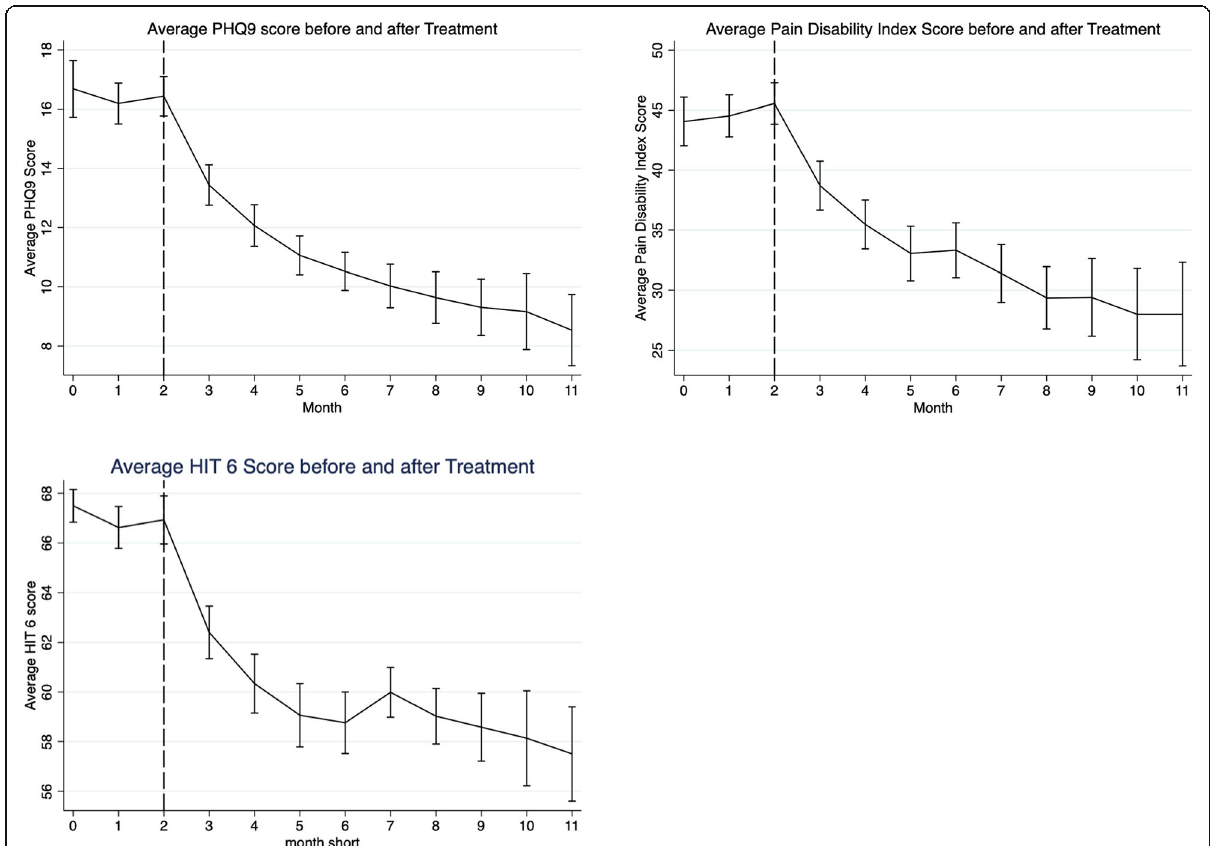
Fig. 5 Graphs showing change in mean quality of life scores (PHQ9, HIT-6, and PDI) before and after commencing erenumab. Three months of baseline data (month 0, 1, 2) is followed by 9 months of post-treatment data (month 3 – 11). Error bars represent standard error of the